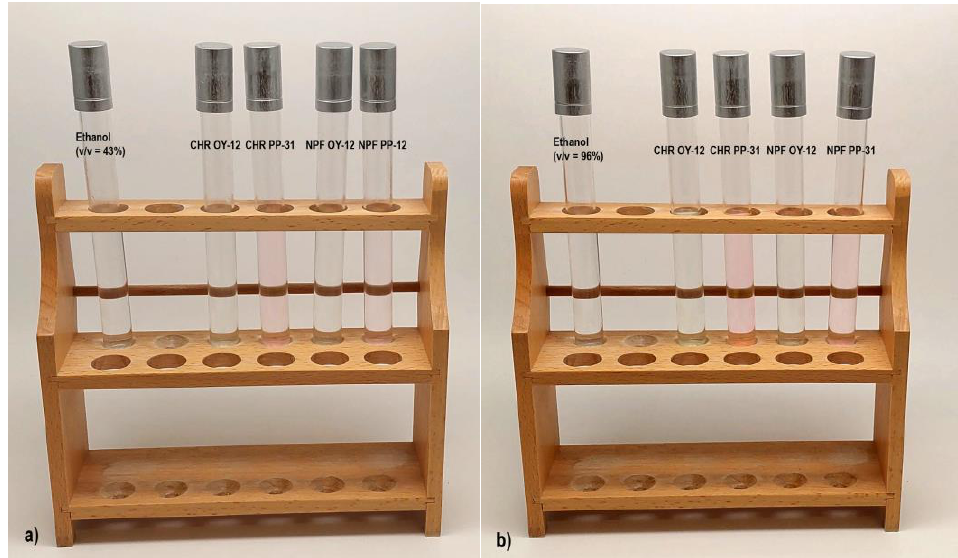
Figure 5. Bleeding of colorants from prints obtained with OY-12 and PP-31 TC inks into solvents: ( a ) 43% ethanol solution and ( b ) 96% ethanol solution.